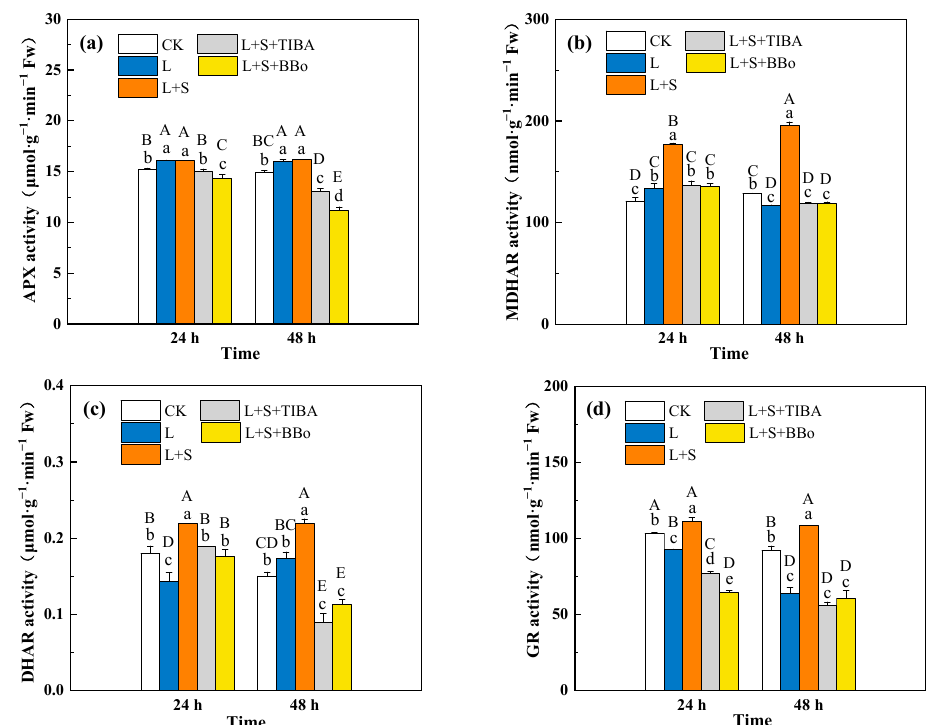
Figure 6. Effects of exogenous sucrose and IAA inhibitors on APX ( a ), MDHAR ( b ), DHAR ( c ), and GR ( d ) activities of M. baccata under sub-low temperature. Bars indicate means ± standard error ( n = 3). The lowercase letters represent significant differences between treatments ( p < 0.05). The capital letters represent significant differences between full data ( p < 0.05). The comparison of means is based on the Duncan’s multiple range test. CK, control treatment; L, sub-low root-zone temperature (5 ◦ C); L + S, 5 ◦ C + 90 mmol · L − 1 sucrose; L + S + TIBA, 5 ◦ C + 90 mmol · L − 1 sucrose + 500 µ mol · L − 1 2,3,5-triiodobenzoic acid; L + S + BBo, 5 ◦ C + 90 mmol · L − 1 sucrose + 300 µ mol · L − 1